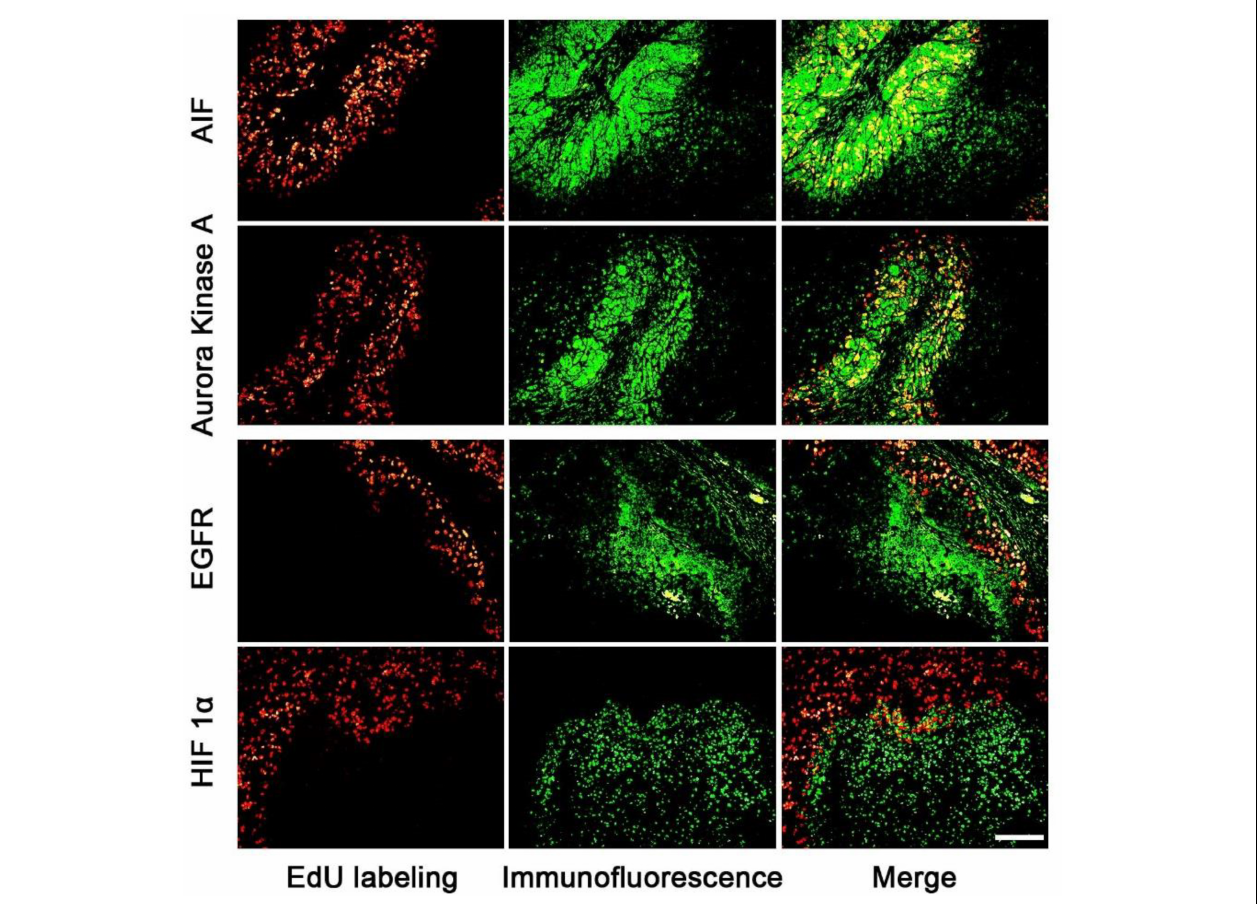
FIGURE 3 | The correlation of the expression area of cancer related proteins and the proliferating area in tumor tissues. The images of cancer related proteins (green) and the proliferating area (red) were superimposed to observe the correlation of them. The proteins of AIF and Aurora kinase A mainly expressed in the proliferating areas, but EGFR and HIF proteins mainly expressed in the non-proliferating area. Scale bar indicates 2